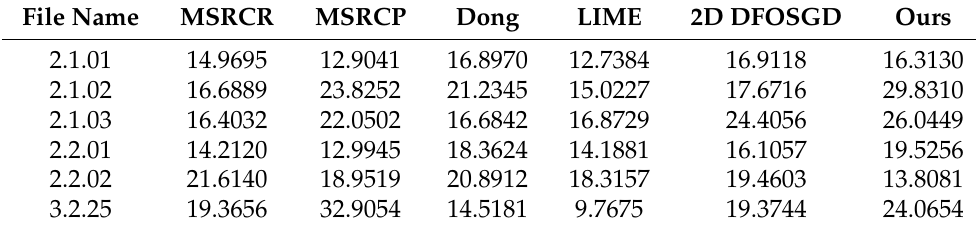
Table 2. The comparison of